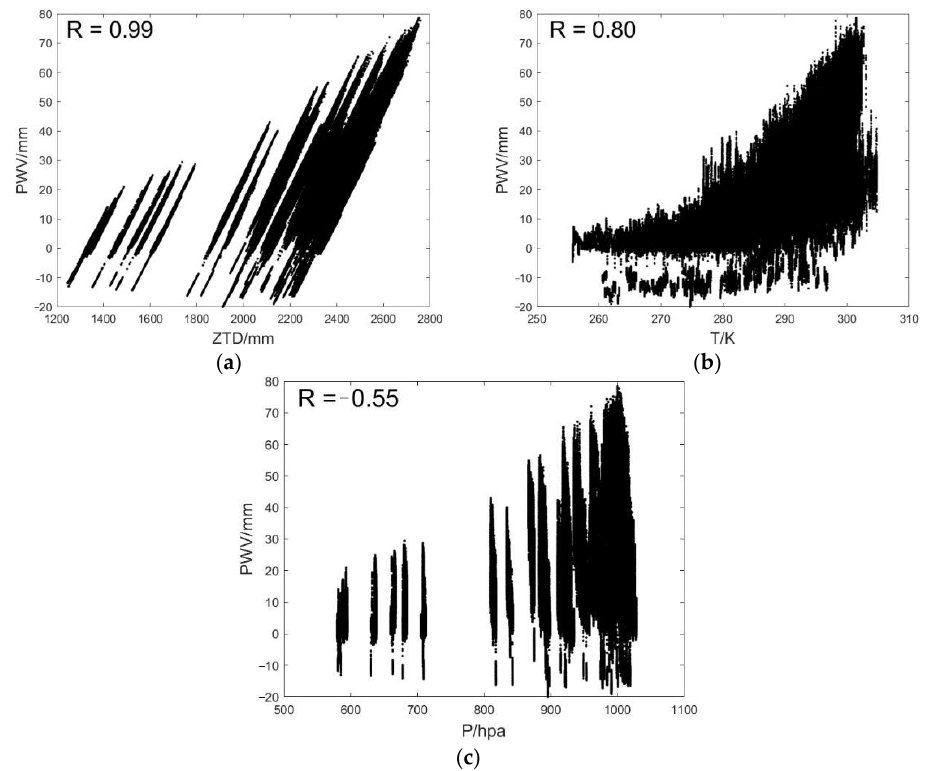
Figure 2. Correlation analysis between PWV and GNSS-ZTD ( a ); temperature ( b ); pressure ( c